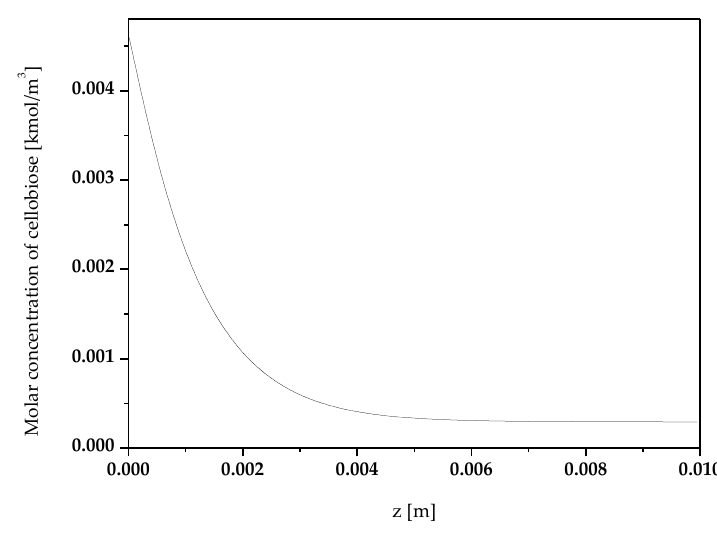
Figure 3. Molar concentration of cellobiose ( kmol/m 3 ) along the axial coordinate z.